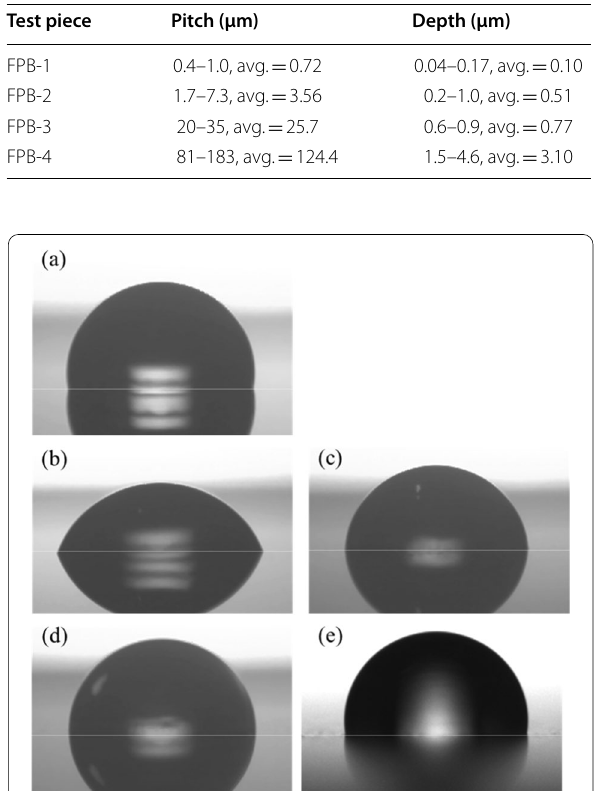
98.5°, b FPB-1, WCA = 90.0°, and e FPB-4, WCA =